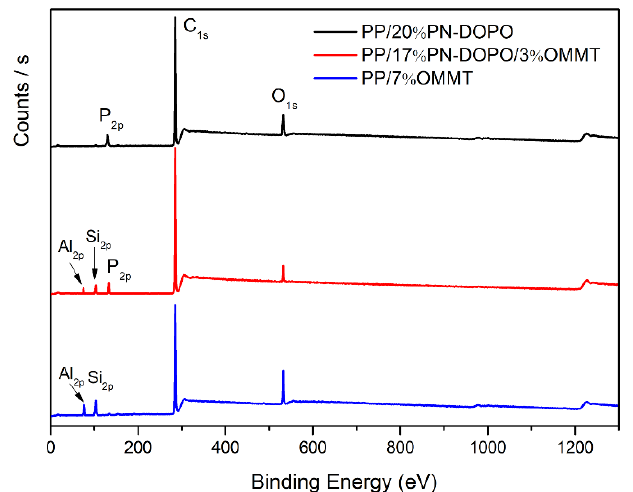
Figure 5. The XPS spectrum of the char residues of flame-retarded PP composites.